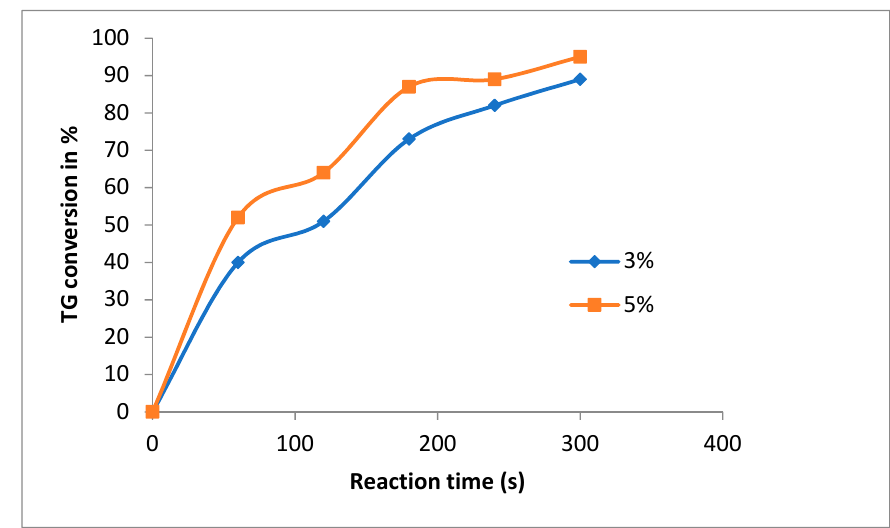
Figure 7. Ultrasound in batch reactor 4:1 (methanol:canola oil), Catalyst (guanidine A) 3 and 5% mol, US 60% amplitude, temperature 35 °C.